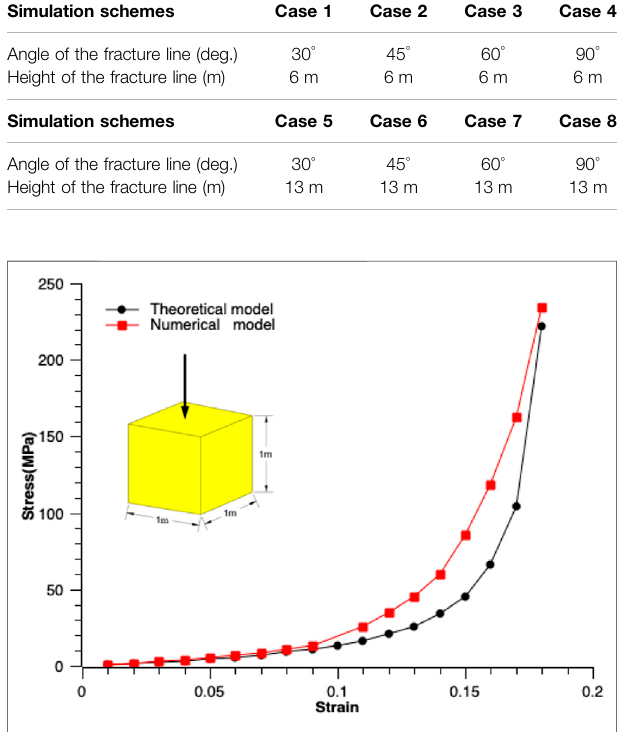
FIGURE 11 | Comparison of the stress – strain relationship obtained by the numerical model and Salmon ’ s